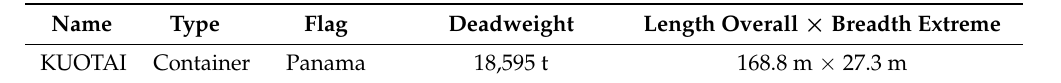
Table 1. Types of AIS data.